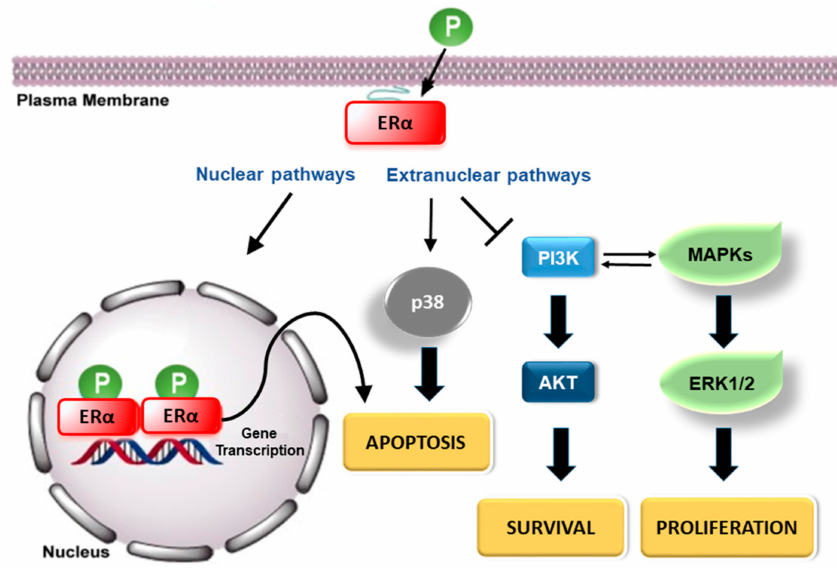
Figure 3. Schematic representation of the 17 β -estradiol (E2) antagonist mechanisms triggered by polyphenols (P) that drive cancer cells to apoptosis in the presence of ER α